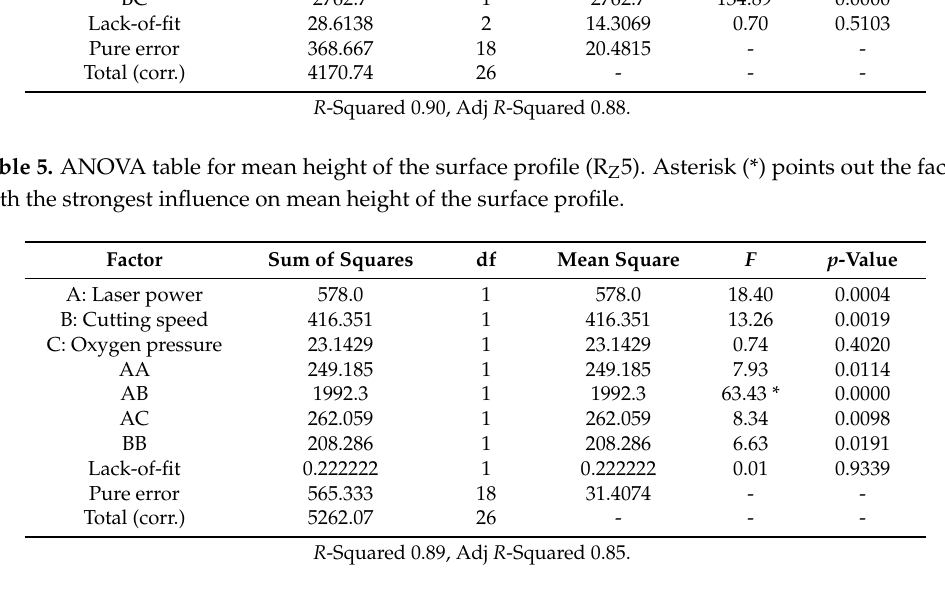
Table 6. ANOVA table for top kerf width. Asterisk (*) points out the factor with the strongest influence on top kerf width.